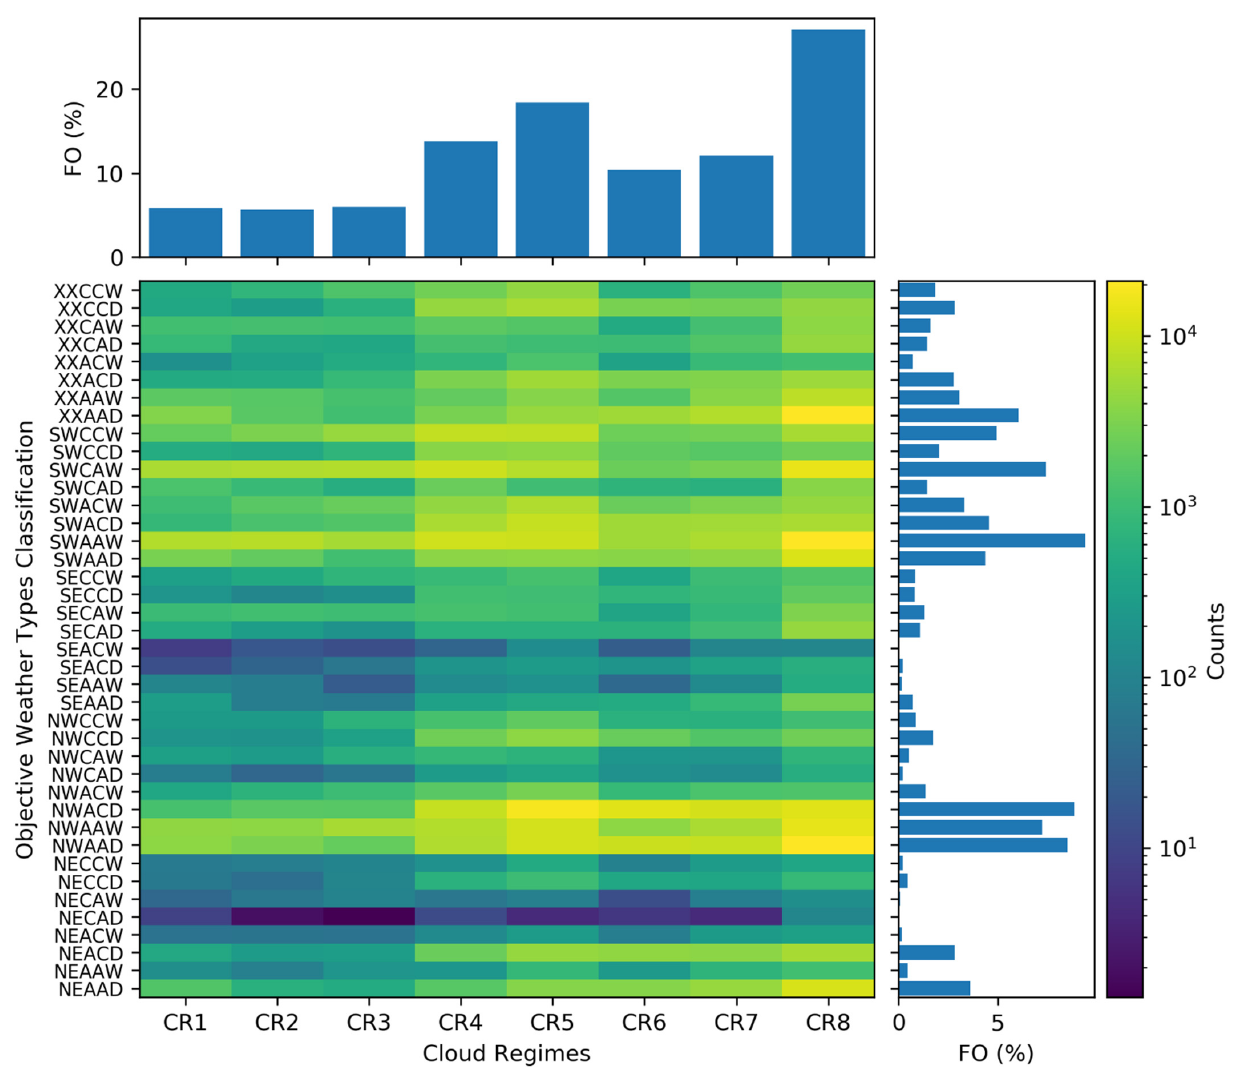
Figure 11. Contingency table between occurrences of the 40 weather types (WTs) of the Objective Weather Type Classification and the 8 CRAAS cloud regimes (CRs) over Germany for the 2004–2017 period. The two side plots show the relative frequency of occurrence (RFO) of the 40 WTs and the 8 CRs.